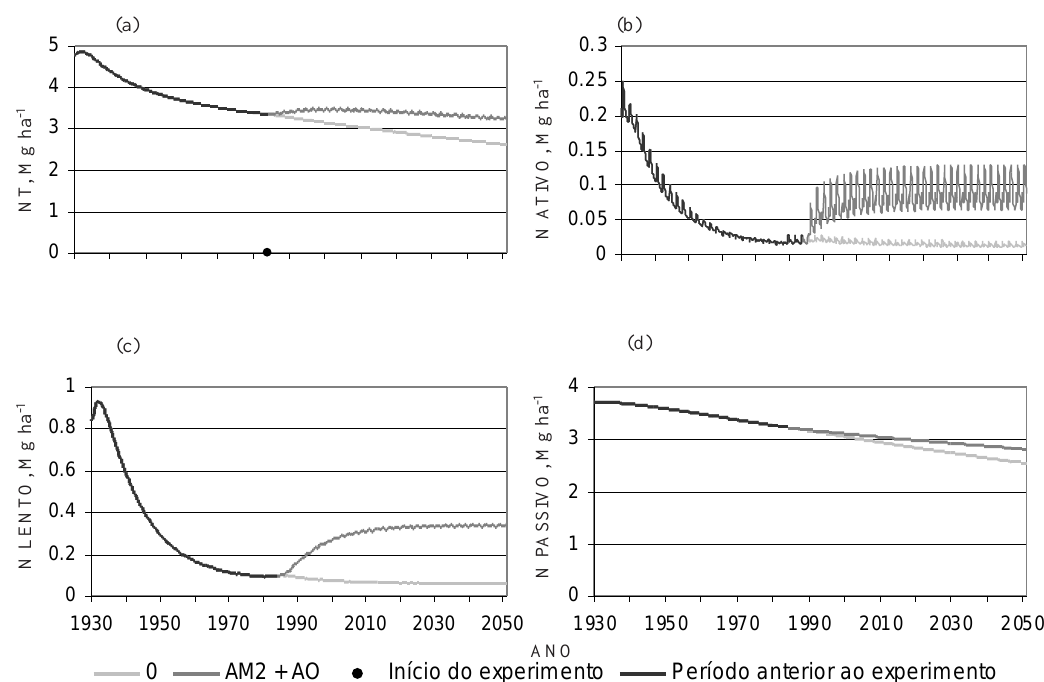
Figura 4. Estoques de nitrogênio total (NT) (a) e dos compartimentos de nitrogênio, ativo (b), lento (c) e passivo (d) (0-20 cm), nos tratamentos: 0 (testemunha) e AM2 + AO (500 kg ha -1 de 4-14-8 + 40 kg ha -1 de N em cobertura + adubo orgânico, 40 m 3 ha -1 ).